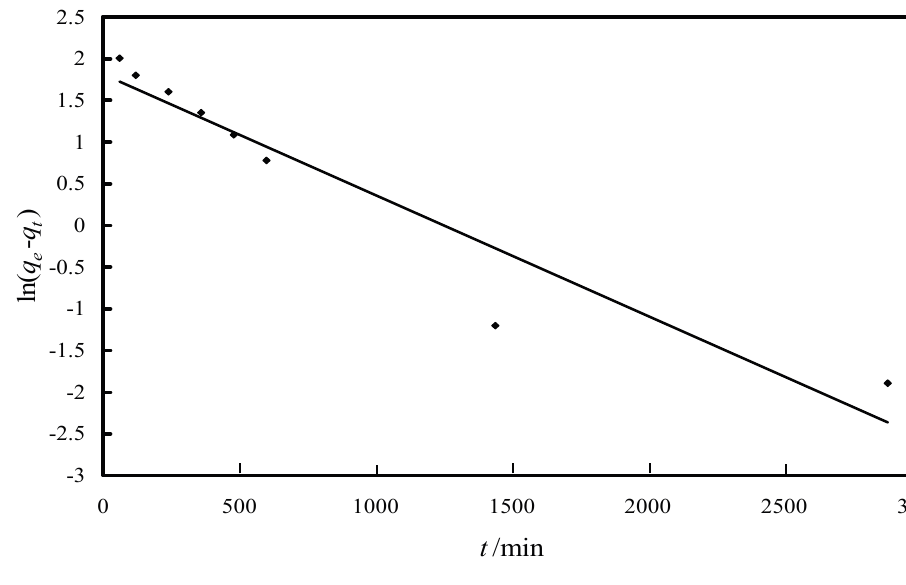
Figure 5. Linear model of the pseudo-first-order reaction kinetics of As(V) adsorption onto Fe-XAD8-DEHPA resin.